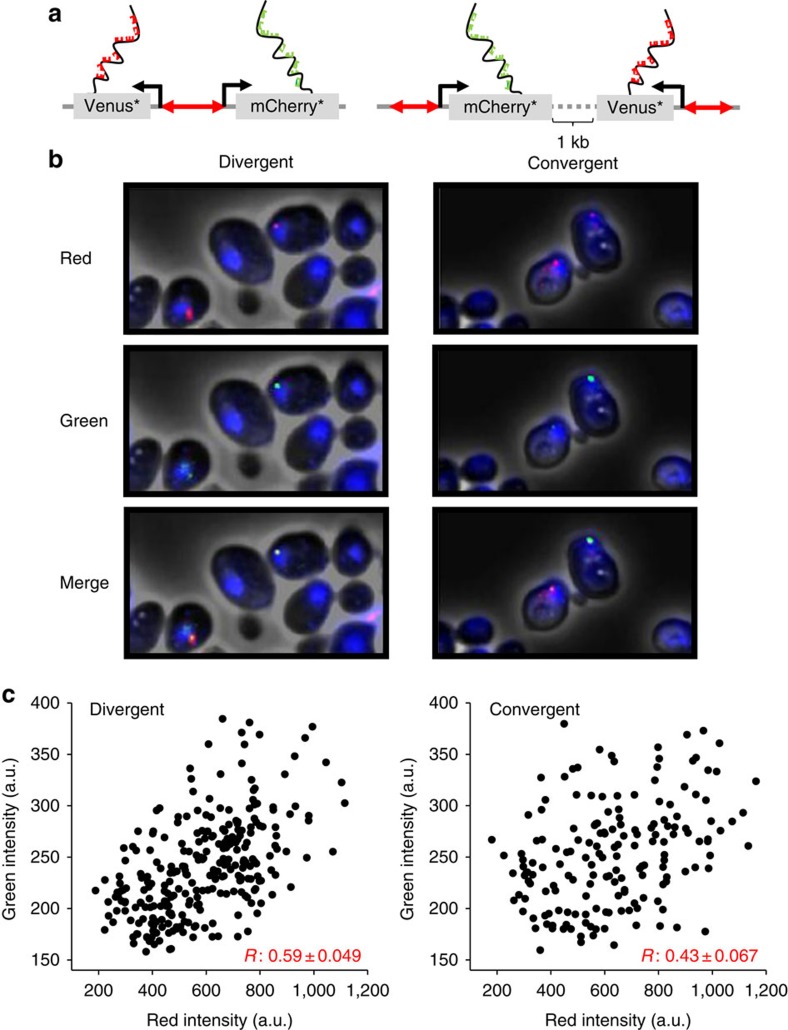
smFISH detected higher correlation in divergent transcription.(a) Cartoons illustrating the smFISH method for probing the divergently (left) or convergently transcribed (right) Venus* and mCherry* genes. The black curves represent nascent mRNAs at the transcription site (TS). The red and green blocks represent the CAL Fluor Red 610-labelled probes for Venus* and FAM-labelled probes for mCherry* transcript, respectively. (b) Typical FISH images of Venus* and mCherry* transcripts driven by HTA2–HTB2 promoter in divergent (left) or convergent (right) configurations. Phase and DAPI channels merged with red, green or both fluorescent images were shown in the upper, middle or lower panels, respectively. (c) Correlation of the Venus* and mCherry* transcriptional activities. Each dot represents the fluorescent intensity of one TS in the red (x) and green (y) channels. The R values are Pearson correlation coefficient (mean±s.e.m.; see Methods). Number of TSs: divergent, 272; convergent, 185.